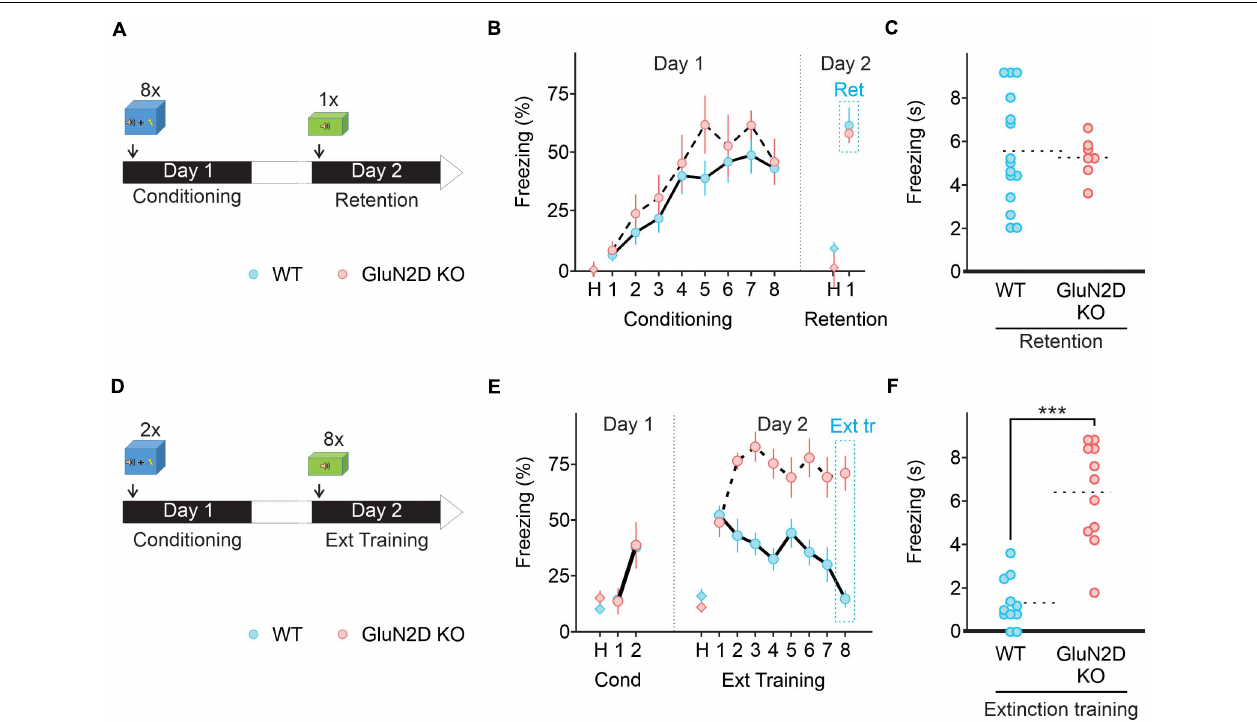
FIGURE 4 | Deletion of GluN2D does not alter fear conditioning learning or memory retention but abolishes extinction learning. (A) Protocol used for fear conditioning. Mice were habituated for 2 min in the conditioning chamber (context A) and exposed to eight pairings of a 10 s tone that co-terminated with a 1 s foot-shock. Mice were then left in the conditioning chamber for 2 min and returned to their home cage. Next day mice were exposed to a single 10 s tone in context B. (B) Percentage of freezing in wildtype (blue symbols, n = 10) and GluN2D KO mice (red symbols, n = 8) during the habituation period (H), the conditioning training (tones 1–8) and retention test tone. (C) Freezing time in individual animals during fear memory retention test. Mean values are represented as doted lines. (D) A two pairing conditioning paradigm was used. Next day retention and extinction learning (Ext tr) were tested in context B by exposing the animals to eight 10 s tones after 2 min of habituation. (E) GluN2D KO mice (red symbols, n = 11), but not wildtype (blue symbols, n = 11), showed impaired extinction learning assessed on the last tone. (F) Freezing time in individual animals at the end of extinction training. Mean values are represented as doted lines. *** P < 0.001. Values in the time courses are mean ± SEM. Statistical analysis values can be found in the Supplementary Table 1